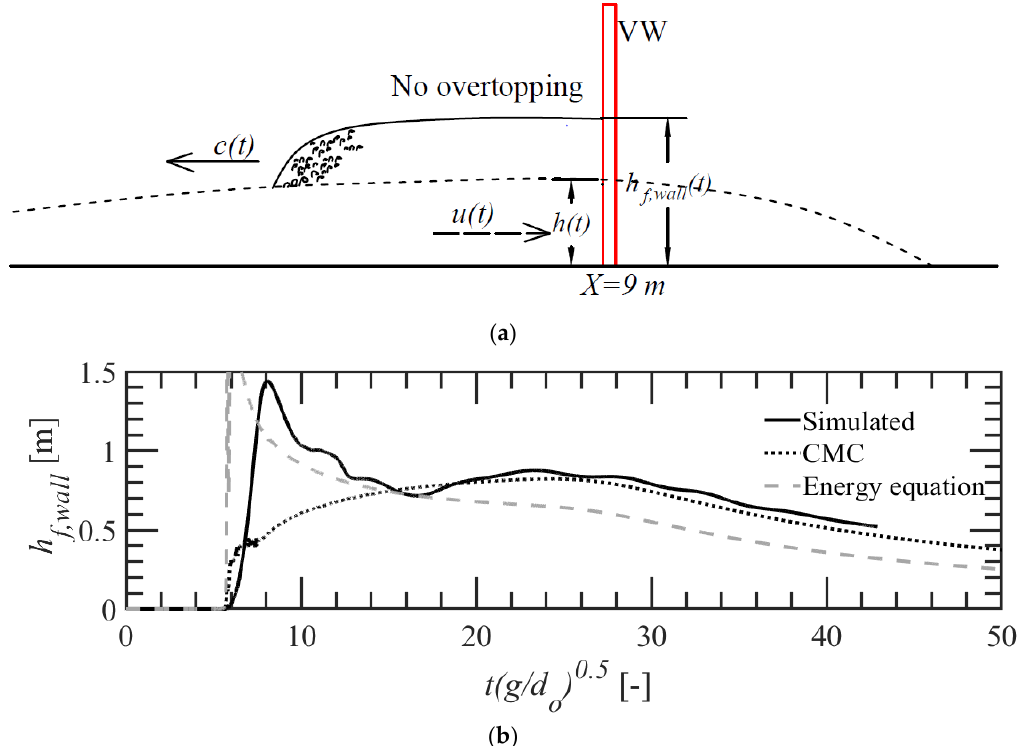
Figure 16. ( a ) Typical bore interaction process with a VW in non-overtopping conditions. The dashed line indicates flow representation in the absence of a VW; ( b ) comparison of water depth at the mitigation wall (VW) upstream; simulated and predicted with CMC (Equation (4)) and Energy equation ( h + u 2 /2g ); test case presented: d o = 0.9 m at X = 9 m.